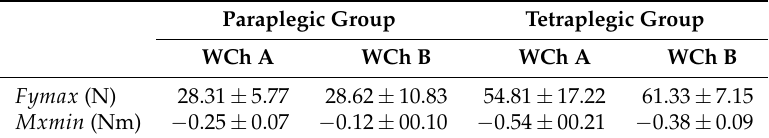
Table 12. Forces and moments that show significance on the wrist (median ±